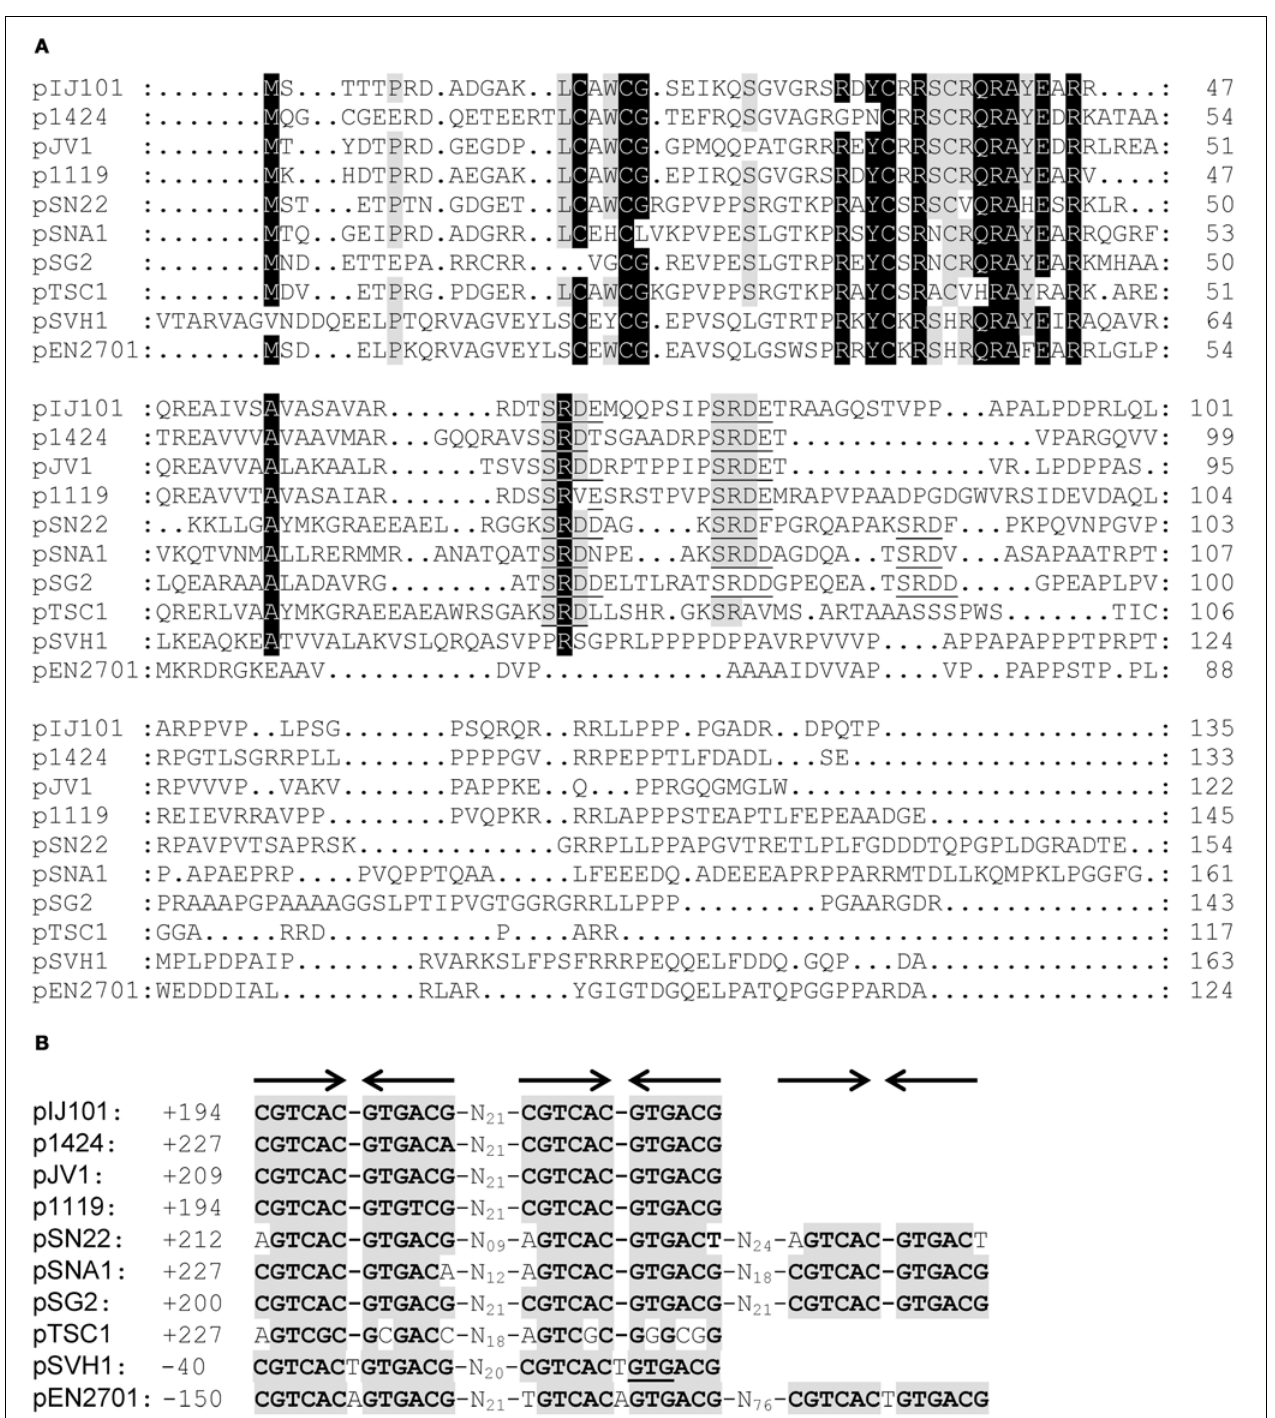
FIGURE 1 | Association of spdA homologs with a conserved palindromic DNA sequence motif on Streptomyces plasmids. Alignment (CLUSTALW) of predicted SpdA proteins encoded by different Streptomyces plasmids (A) . Conserved residues are indicated by shading (black > 90%, gray > 70% identity). Gaps were manually introduced to improve the alignment. The SRDD/E aa motif